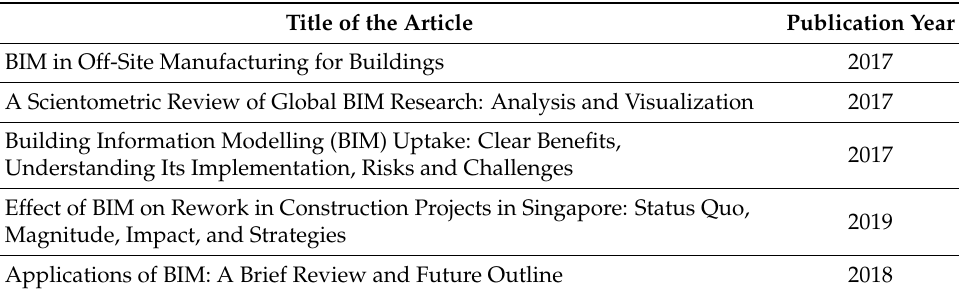
Table A1. Reviewed studies in Section 3.2.1 (sorted by order of